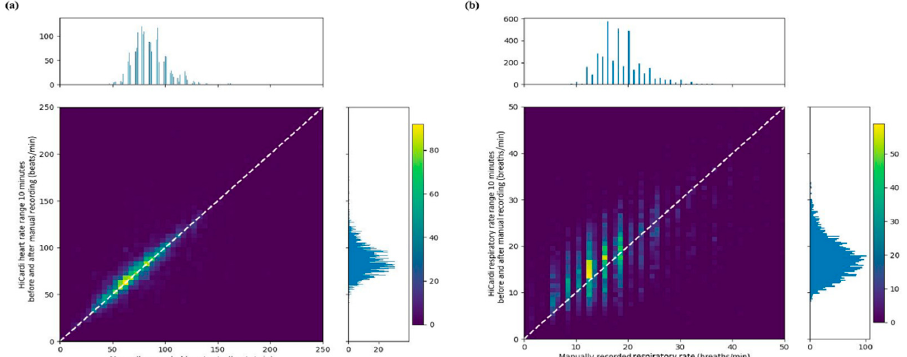
Figure 3. Agreement between the measurements from the wireless monitoring device and manual measurements. ( a ) Agreement between heart rate measurements. ( b ) Agreement between respiratory rate measurements.